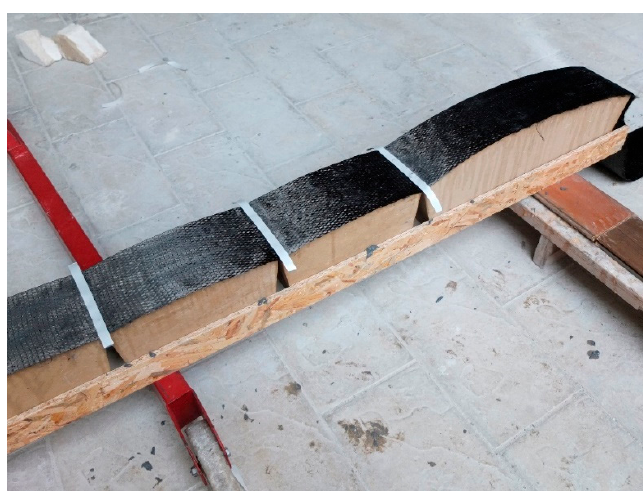
Figure A4. Detail of the free resin line.